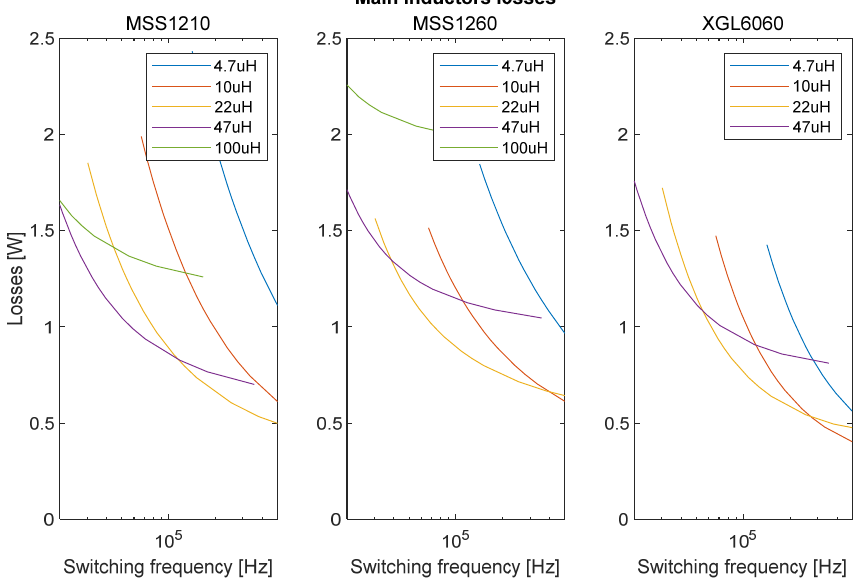
Figure 19. Losses into the main inductors, for multiple inductor values in the three series.